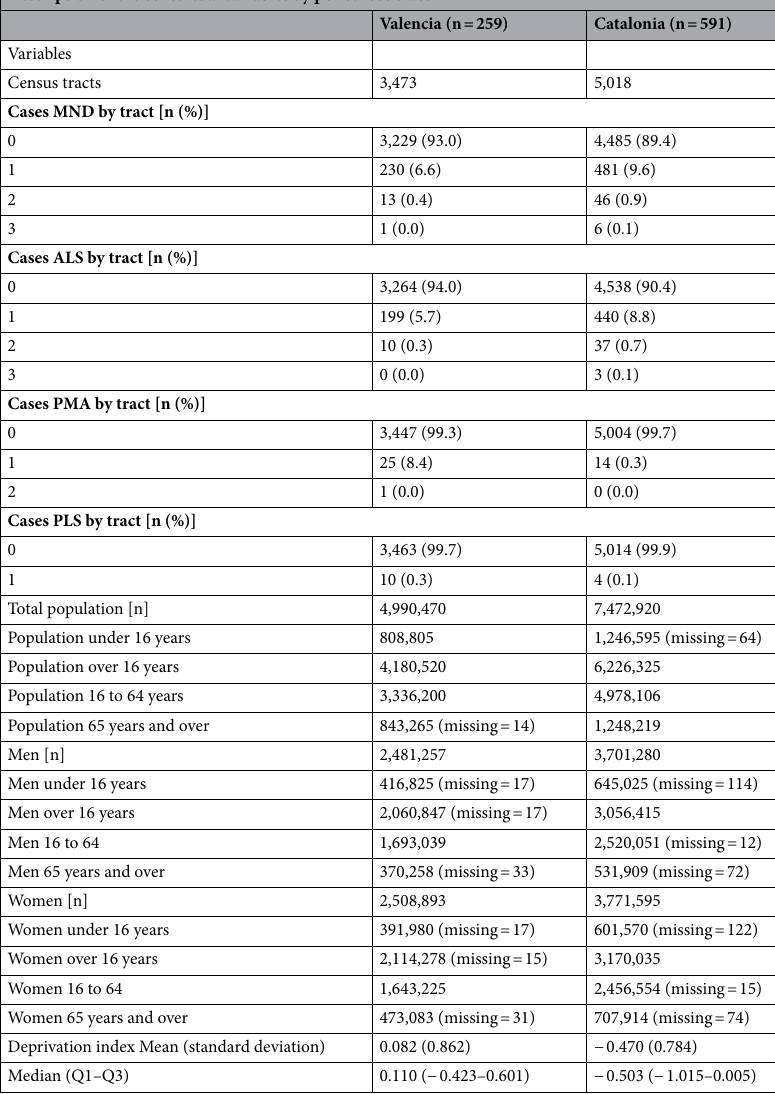
Table 4. Description of the contextual variables by census tract. MND moto neuron disease, ALS amyotrophic lateral sclerosis, PMA progressive muscular atrophy, PLS primary lateral